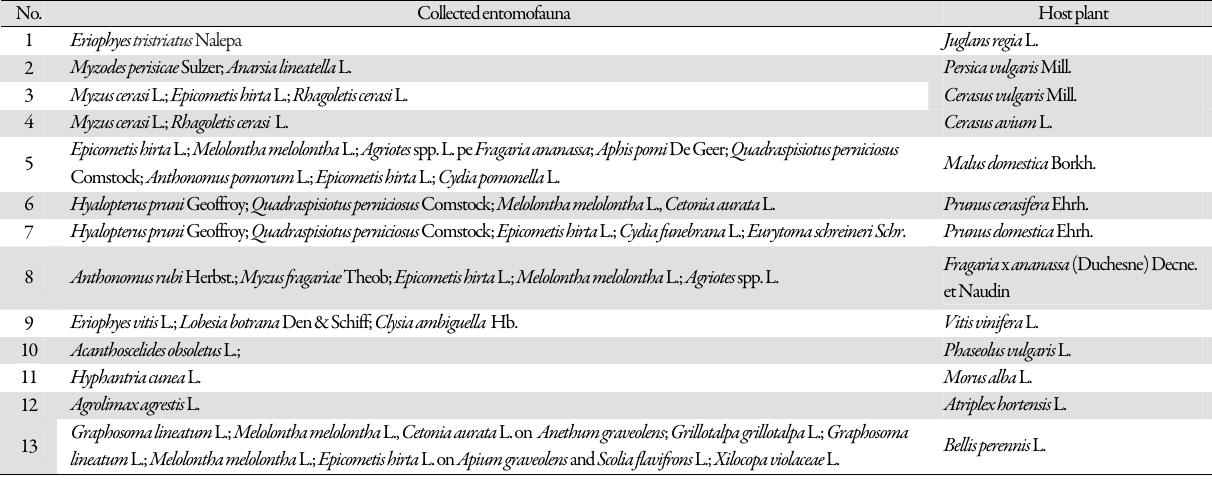
Table 1. Entomofauna collected from the hydrographical basin of the Otăsau River according to the host